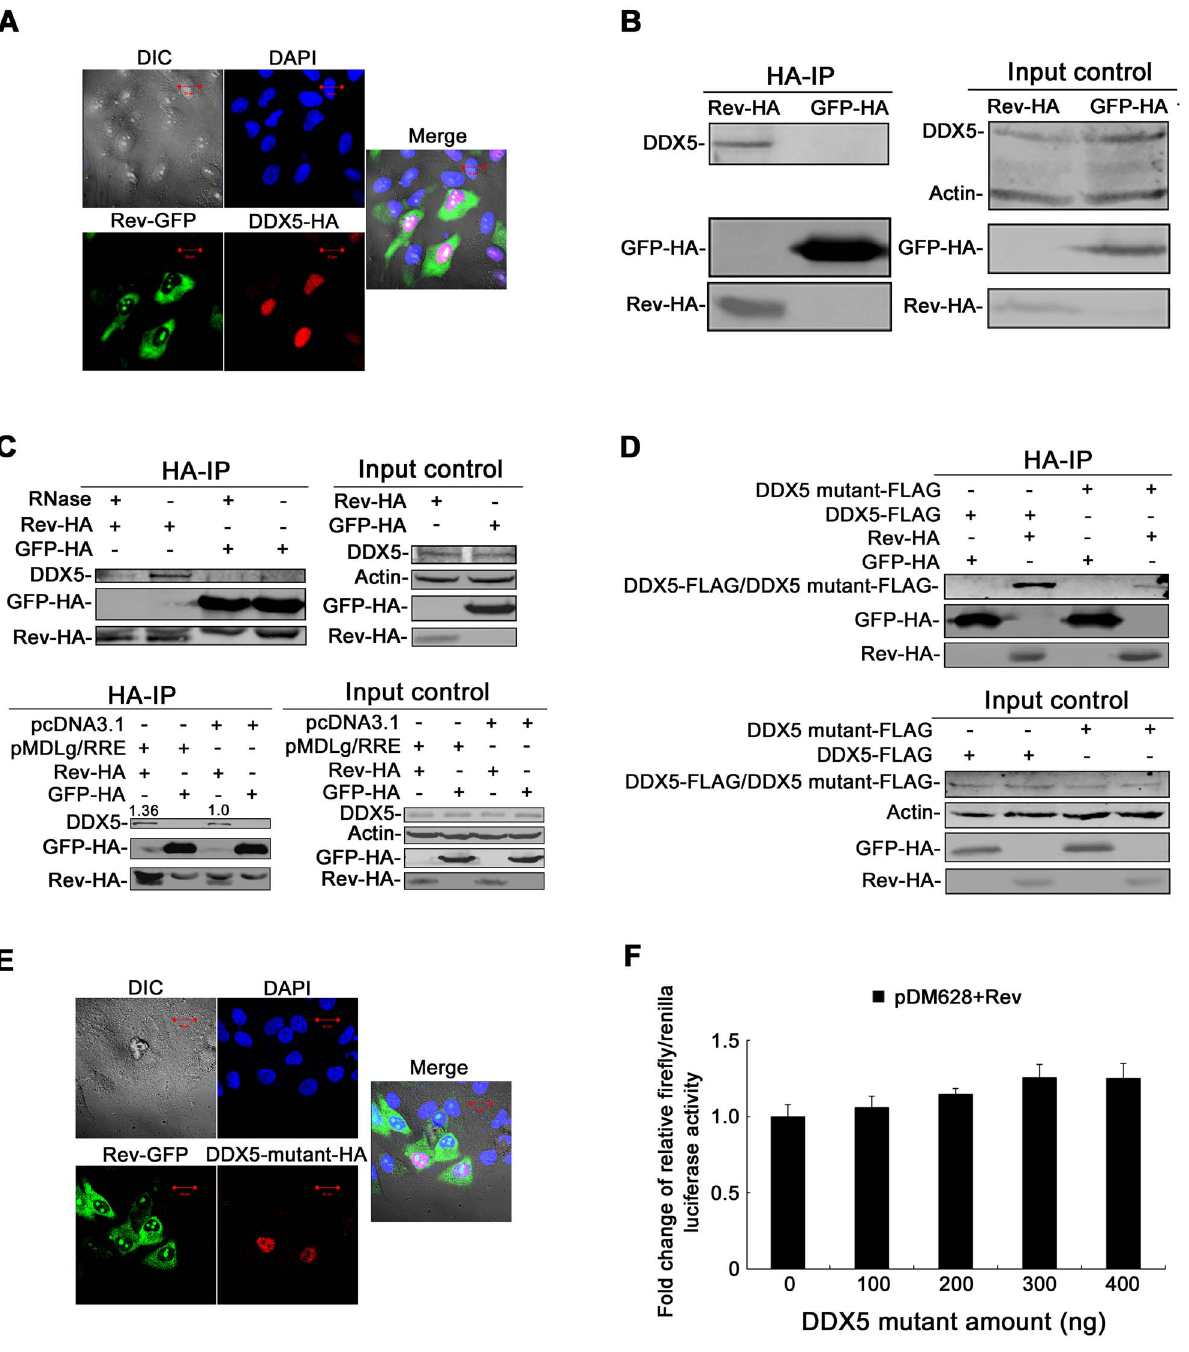
Figure 5. The interaction between DDX5 and Rev is largely dependent on RNA. A and E . Confocal images of transfected HeLa cells. A . HeLa cells were co-transfected with Rev-GFP- and DDX5-HA-expressing plasmids. E . HeLa cells were co-transfected with Rev-GFP- and DDX5 mutant-HA- expressing plasmids. A and E . At 36 h p.t., the transfected cells were observed for fluorescence by confocal laser scanning microscopy. B and C (Top panel). The transfected HeLa cells expressing Rev-HA or GFP-HA were lysed and immunoprecipitated with anti-HA agarose beads. B . Anti-HA immunoprecipitates were analyzed by Western blotting with anti-HA or anti-DDX5 antibody. C (Top panel). The immunoprecipitates were treated with or without RNase mixture. Samples were analyzed by immunoblotting using anti-HA or anti-DDX5 antibody. C (bottom panel). HeLa cells were co-transfected with pcDNA3.1-Rev-HA (pcDNA3.1-GFP-HA as a control) and pMDLg/RRE (pcDNA.3.1 as a control) were lysed and immunoprecipitated with anti-HA agarose beads. Anti-HA immunoprecipitates were analyzed by Western blotting with anti-HA or anti-DDX5 antibody. D . HeLa cells were co-transfected with pcDNA3.1-Rev-HA and pcDNA3.1-DDX5 mutant-FLAG (pcDNA3.1-GFP-HA and pcDNA3.1-DDX5-FLAG as controls). After immunoprecipitation with anti-HA antibody, the immunoprecipitated samples were analyzed with SDS-PAGE and immunoblotting with anti-HA or anti-FLAG antibody. F . The 293T cells were co-transfected with pDM628, pRL-TK (as a transfection normalization reporter), pcDNA3.1-Rev and differing amounts of pcDNA3.1-DDX5 mutant-FLAG (or pcDNA3.1). The cells were lysed at 48 h p.t. for luciferase activity assay.